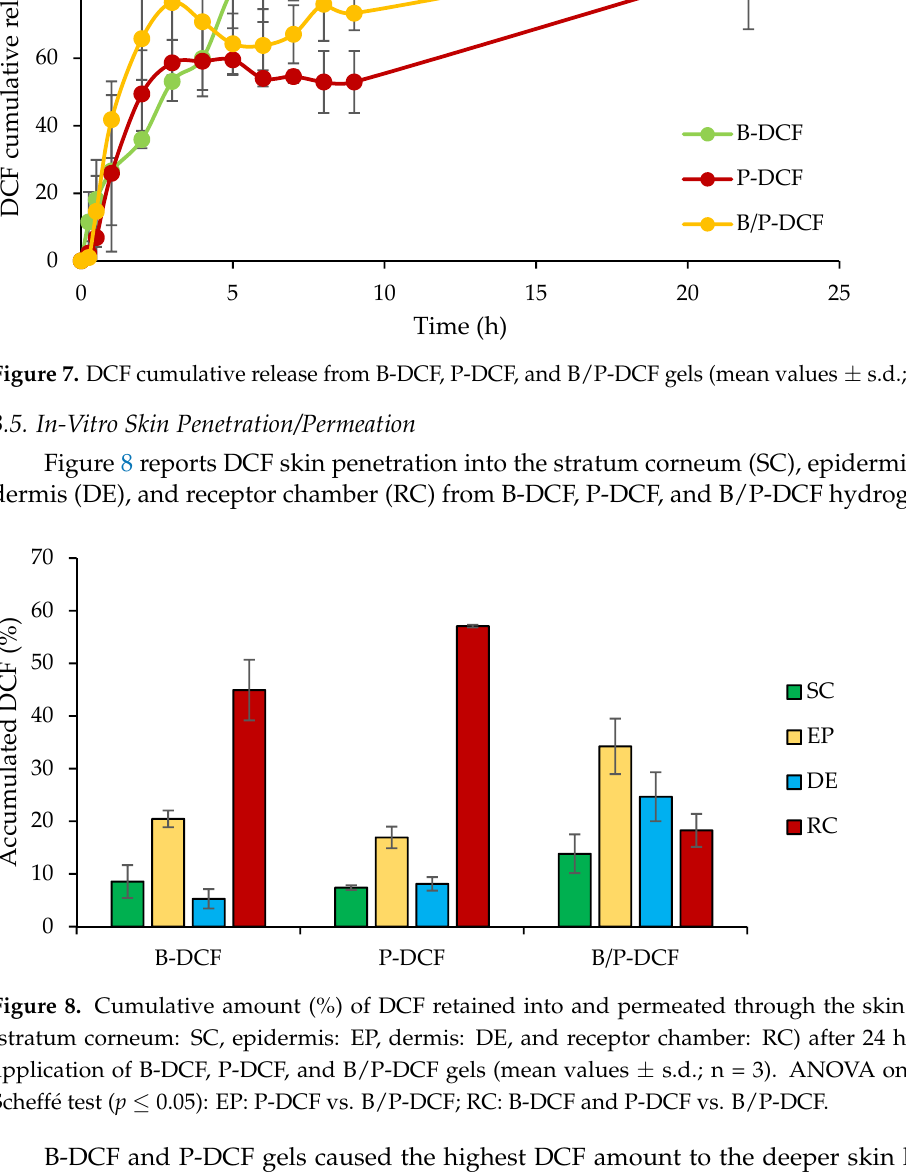
Figure 7. DCF cumulative release from B-DCF, P-DCF, and B/P-DCF gels (mean values ± s.d.; n = 3).